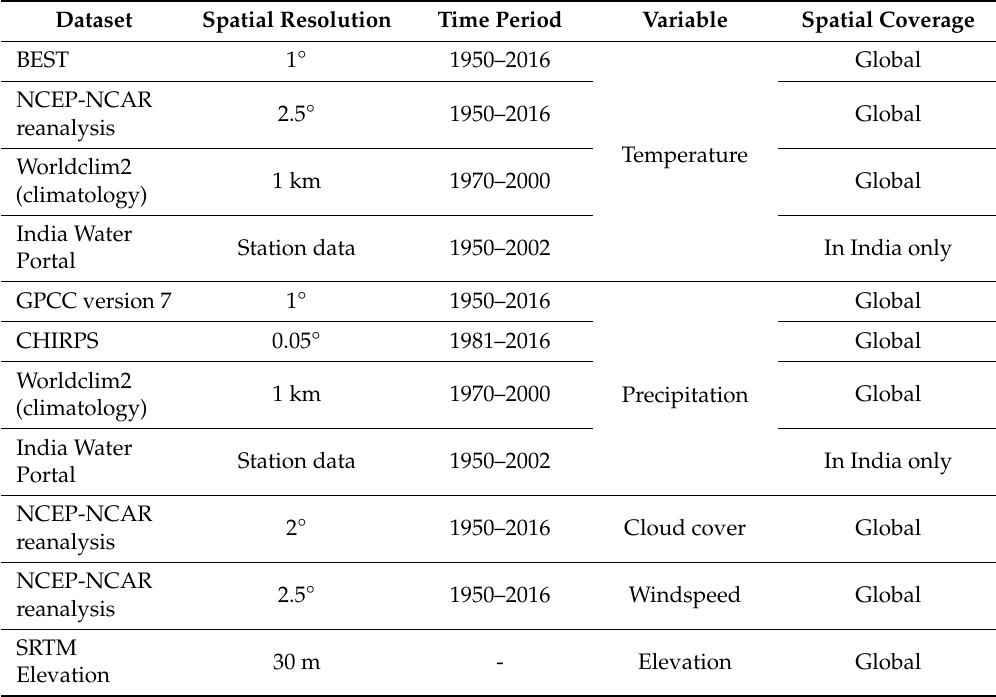
Table 1. Table showing climate datasets